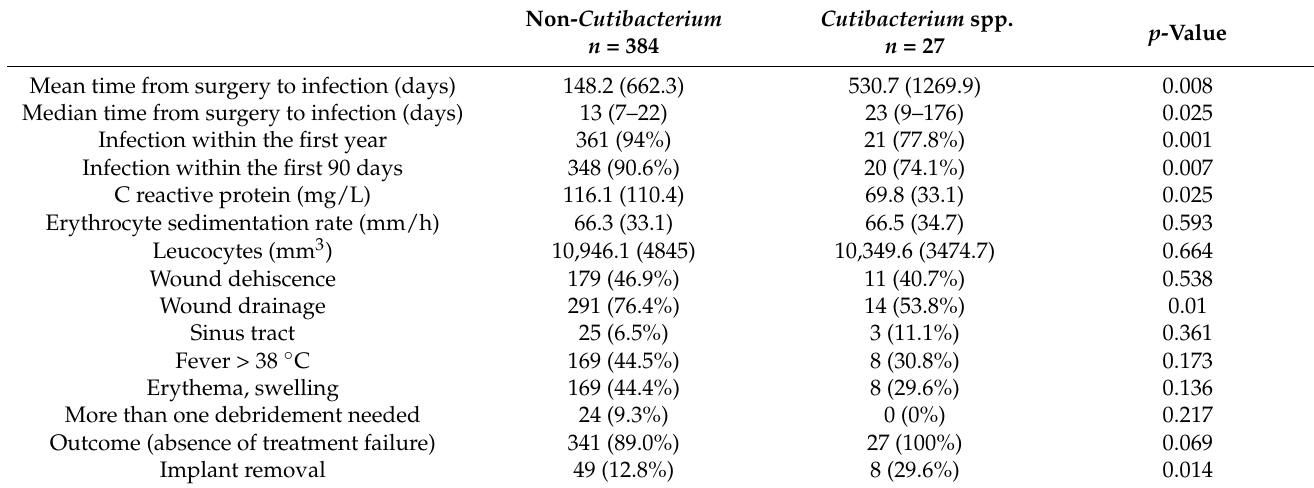
Table 3. Infection